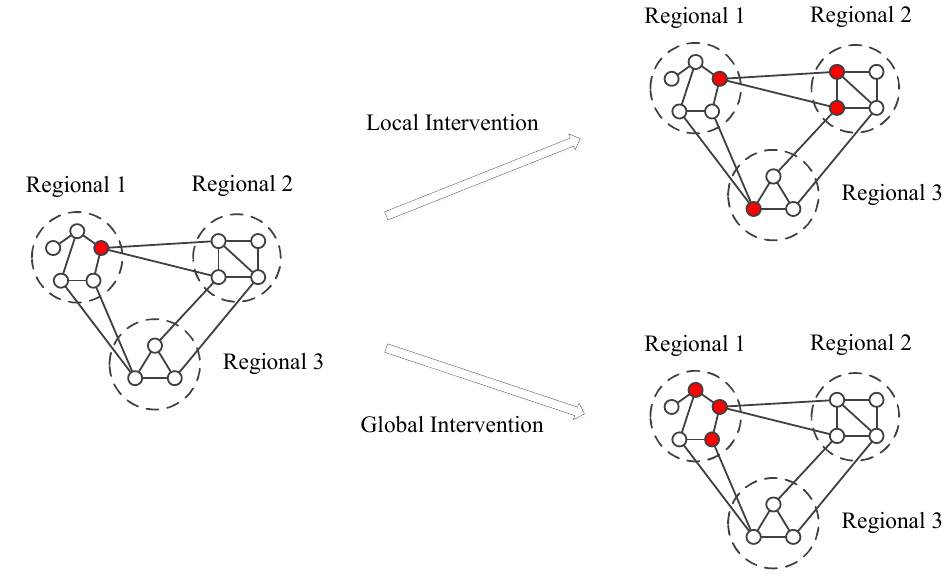
Figure 2. The schematic of the travel restriction of multi-regional-SQEIR model. The solid lines represent relationships between nodes. The dashed-dotted lines represent the regions. The red nodes represent the infected while the white nodes represent the susceptible.